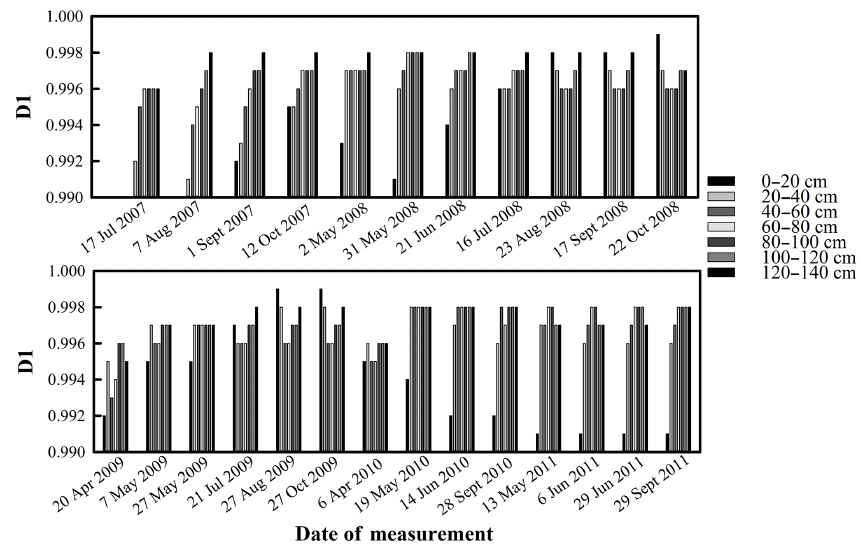
Figure 8. The information dimension ( D 1 ) for soil water storage at different depths (20cm increment) over the whole measurement period.